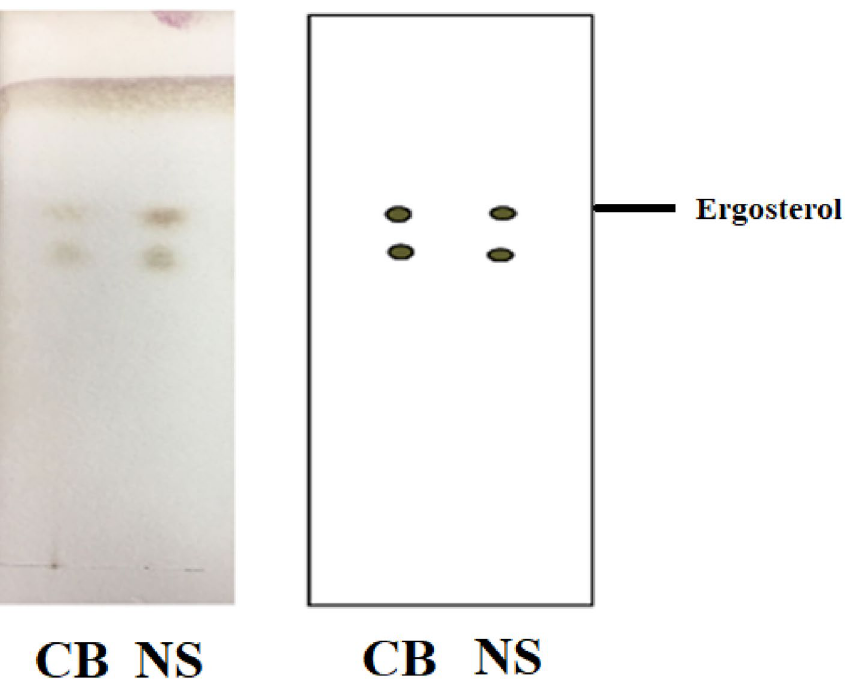
Figure 2. Silica gel chromatography of